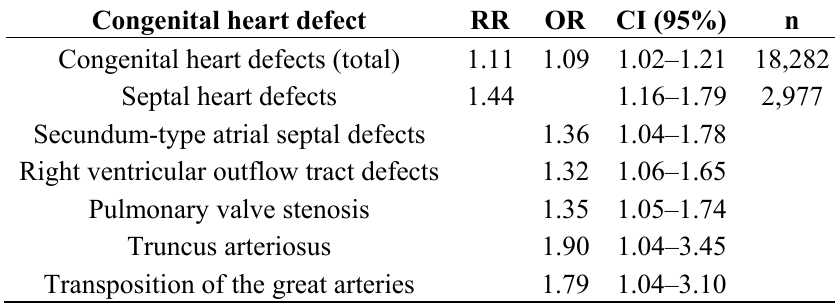
Table 2. Smoking and fetal congenital heart defects; modified after